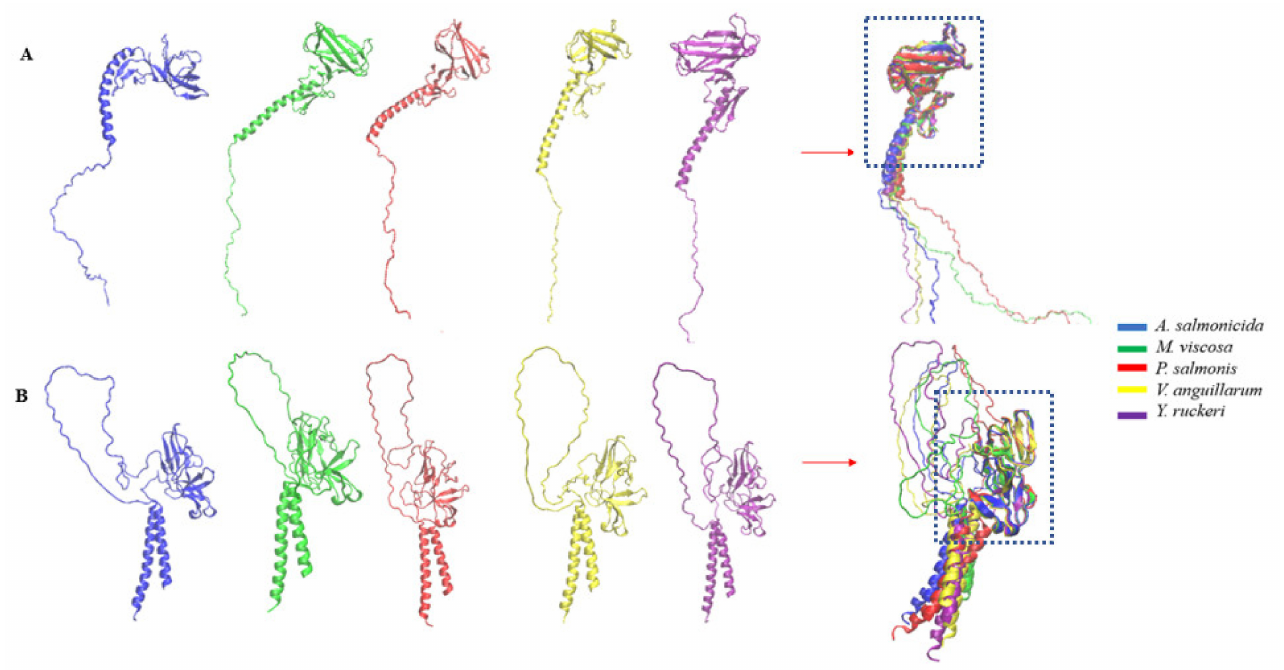
Figure 5. 3D secondary structures of common secreted antigens showing structural homology for bacterial pathogens used in this study. ( A ) flagellar hook assembly protein FlgD; ( B ) flagellar basal- body rod protein FlgG. The regions of conserved domains are highlighted in the boxes (see Table S5 for a complete list of the conserved regions